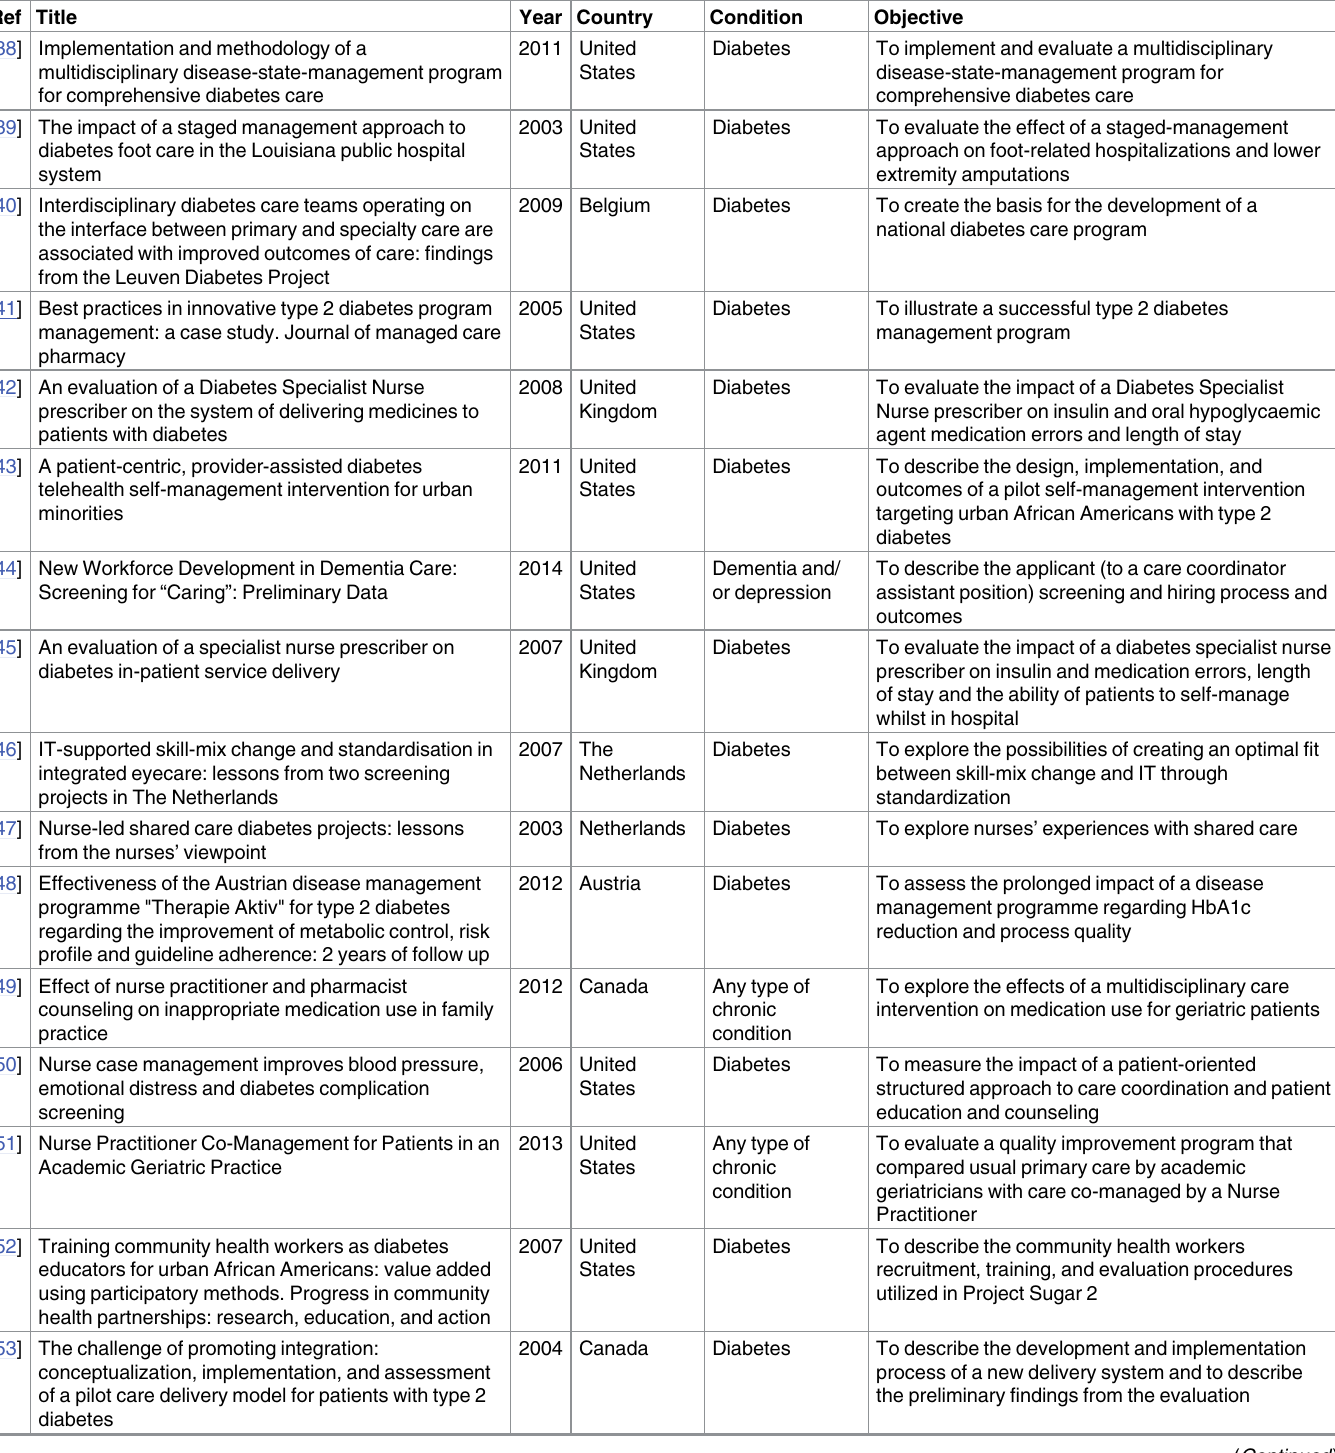
Table 2. Study characteristics of studies included in the literature